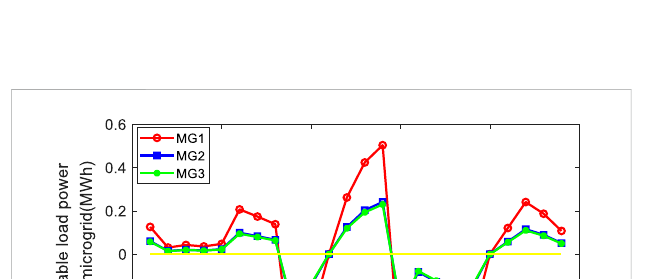
FIGURE 6 Dynamic chart of clearing price.